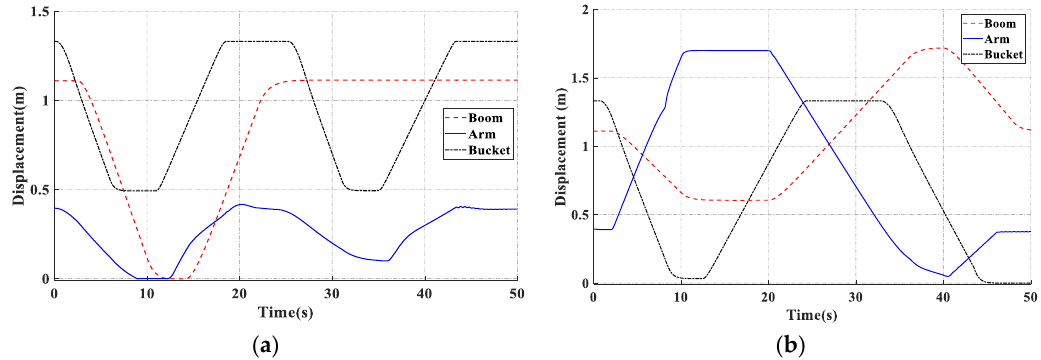
Figure 13. Excavator AMESim hydraulic model [46].